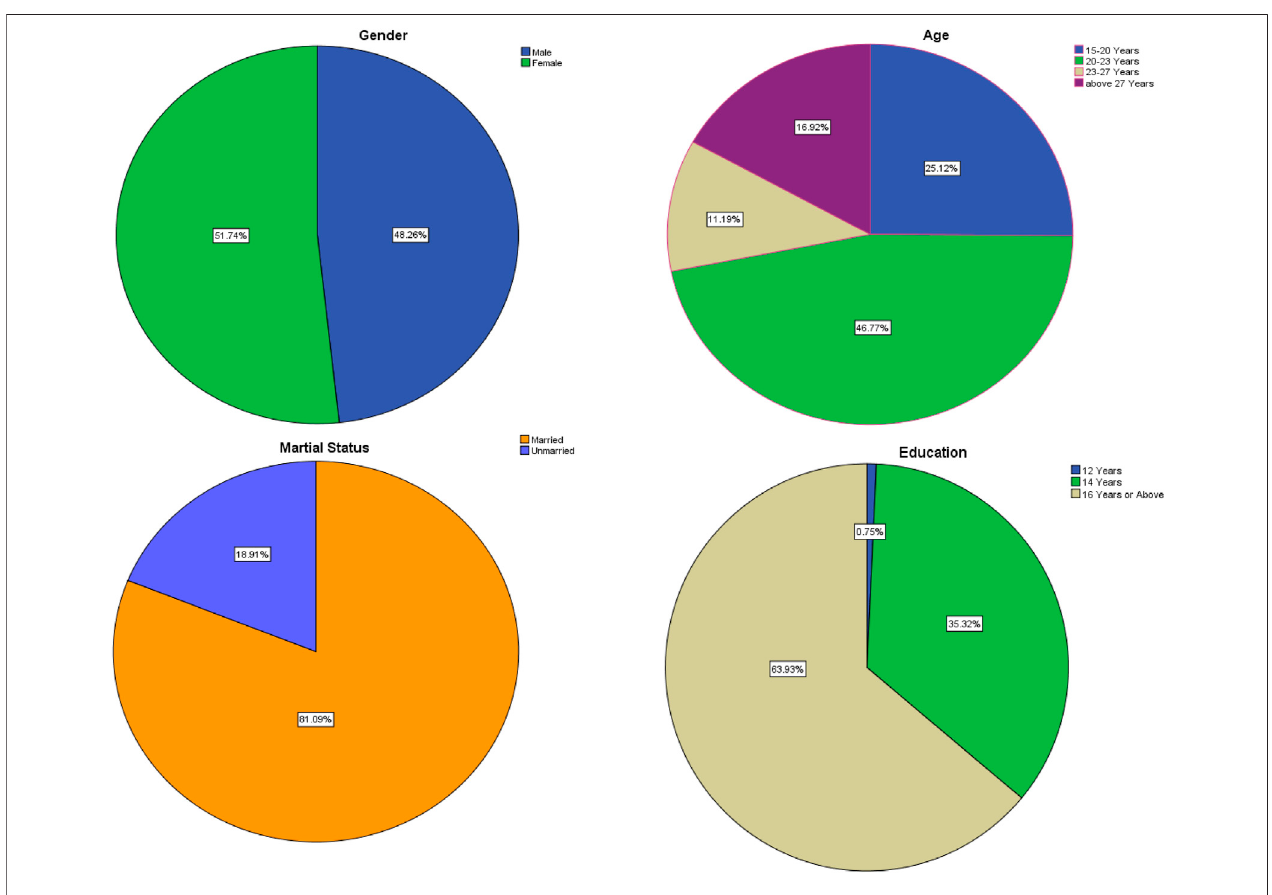
FIGURE 2 | Demographics ’ Pai charts.